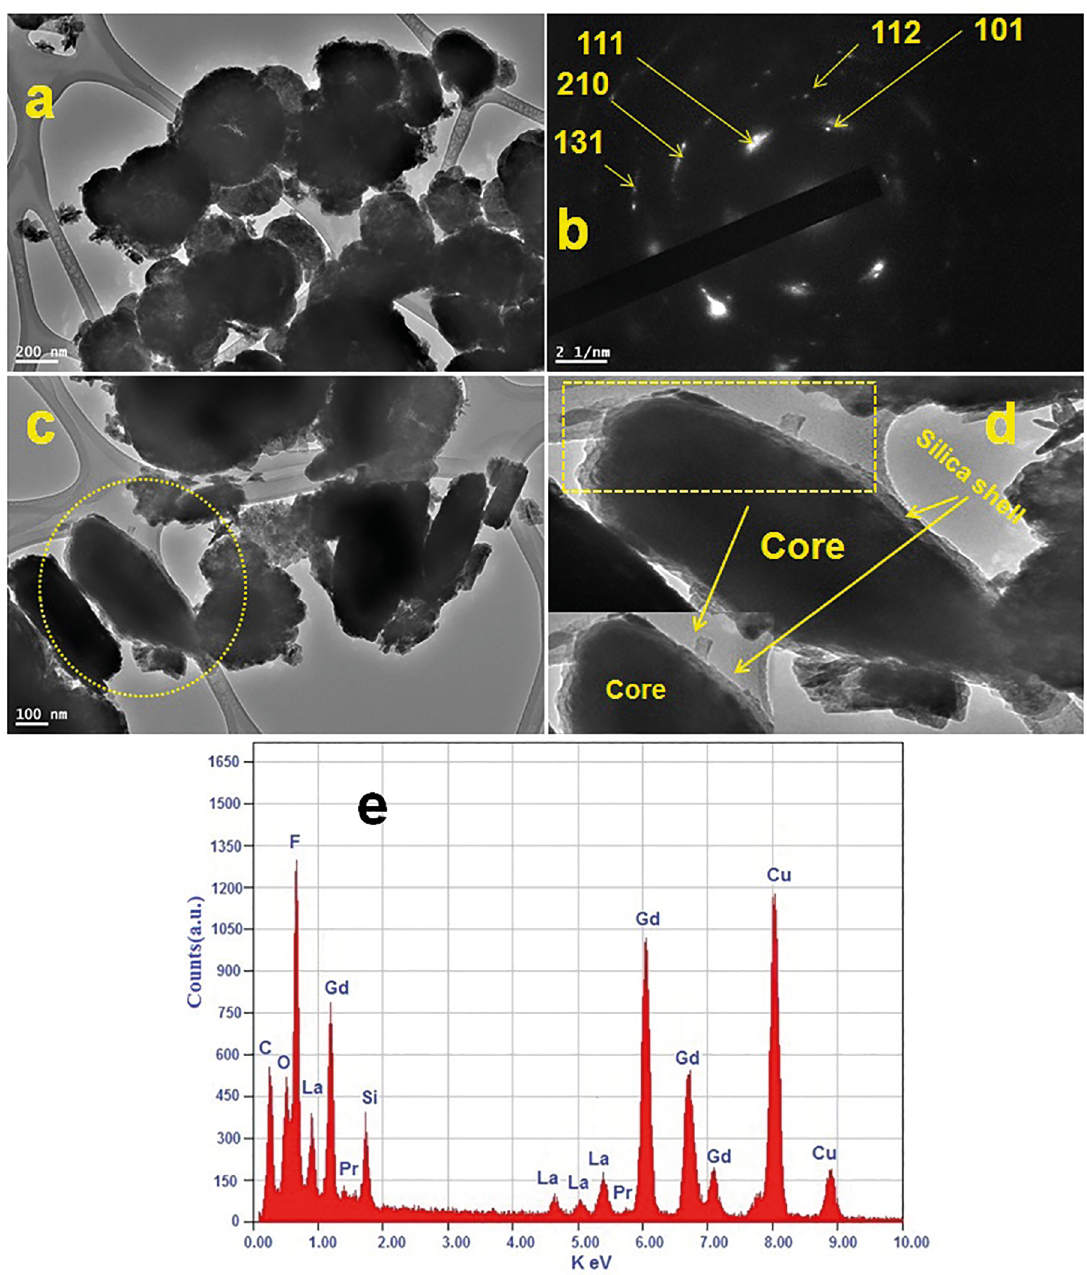
microspheres and (e) Energy dispersive X-ray 2